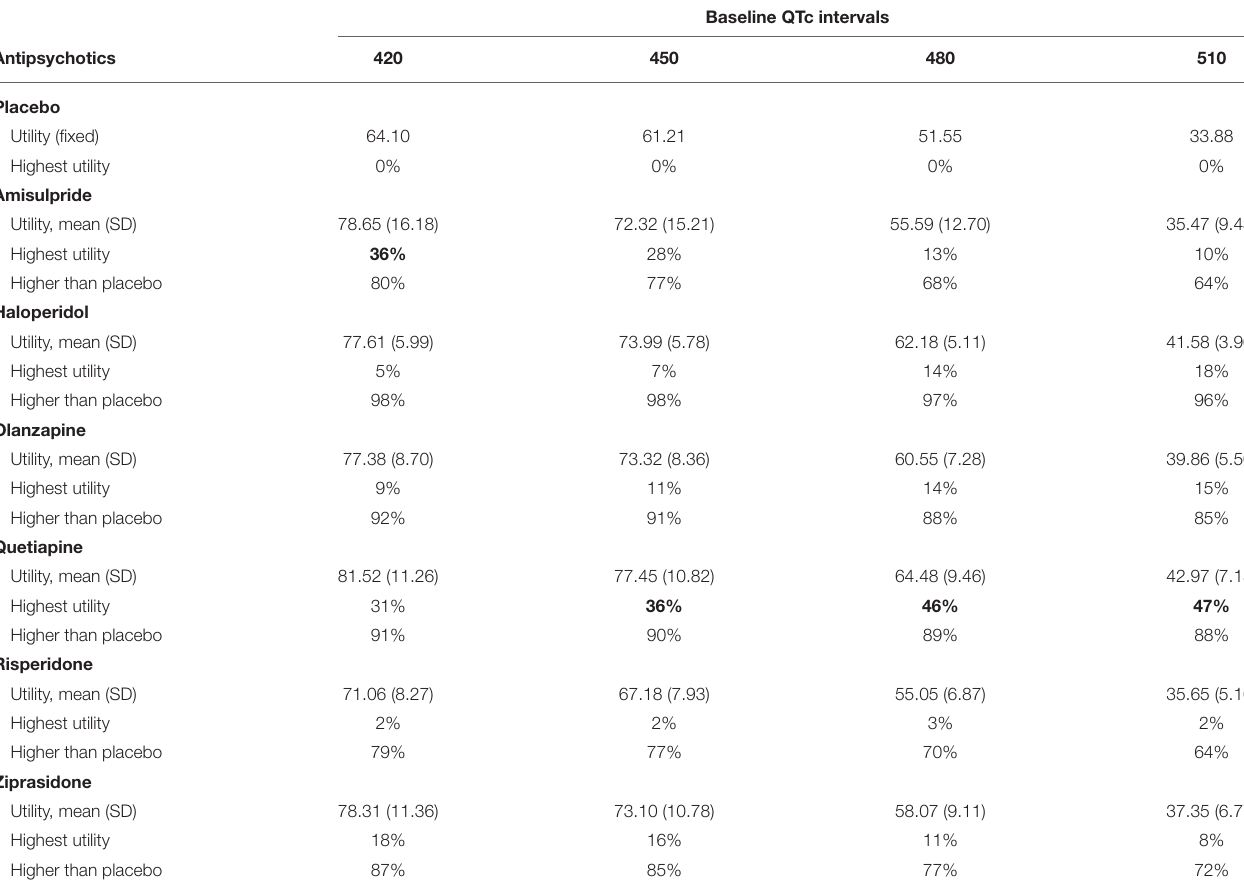
TABLE 3 | Results of probabilistic sensitivity